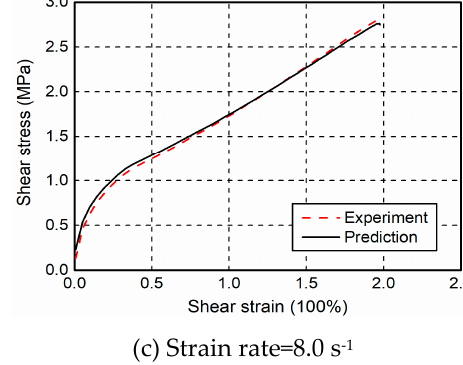
Figure 12. Comparison of monotonic shear tests and model predictions.